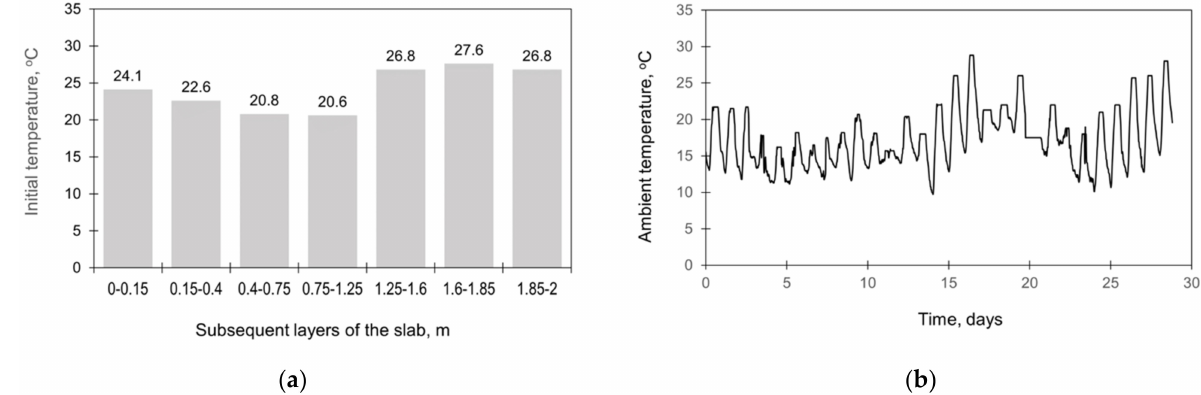
Figure 2. The registered initial temperature of the slab layers ( a ) and the ambient temperature ( b ) [29,30].